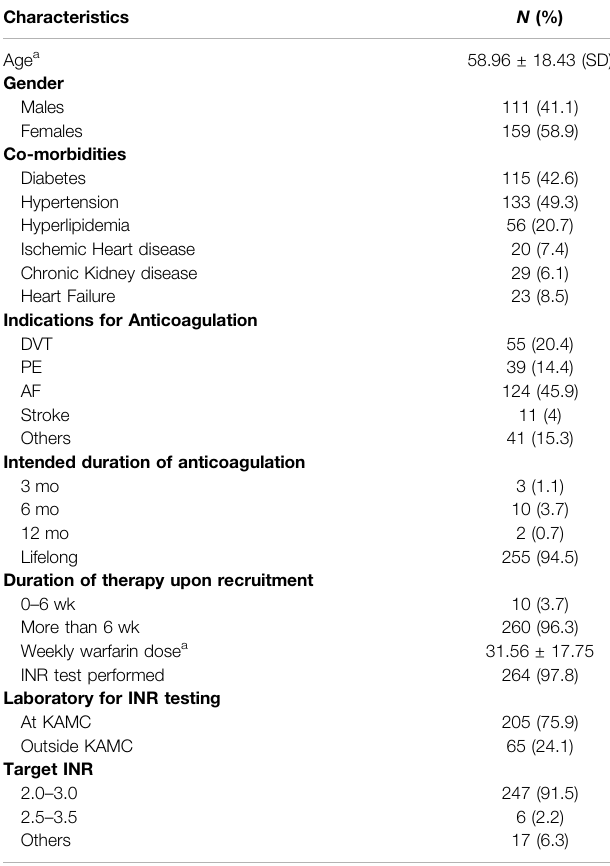
TABLE 1 | Baseline demographic and clinical data of the sample ( n (cid:1) 270).